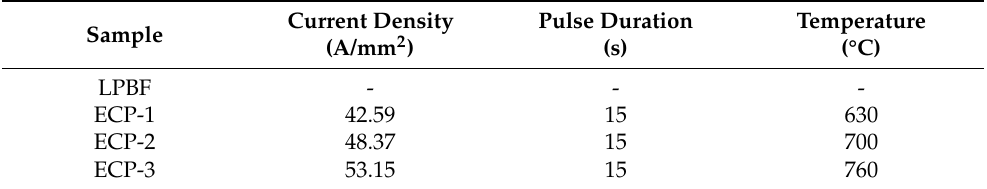
Table 2. The current density, the pulse duration and the corresponding temperature of the samples before and after ECP treatment.